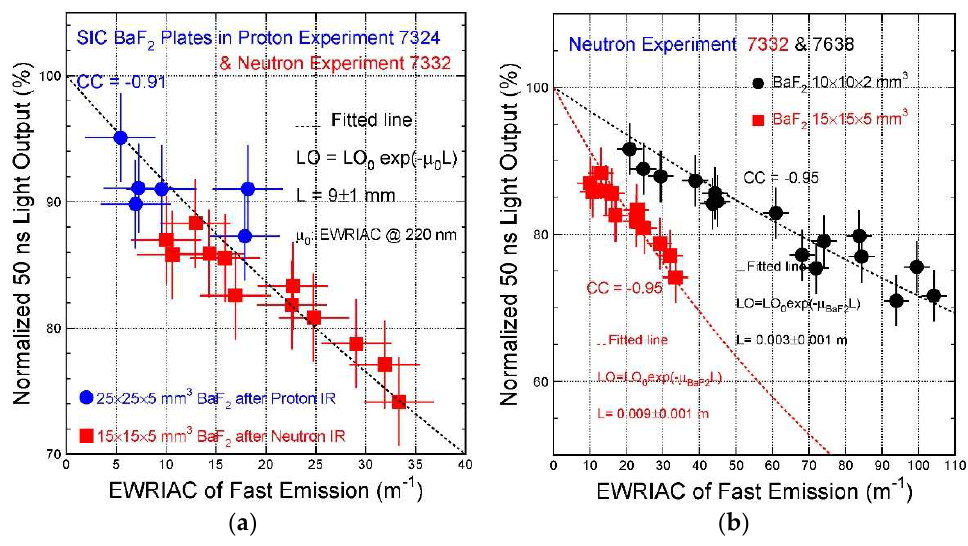
Figure 3. The normalized LO integrated in 50 ns gate is shown as a function of EWRIAC of the 220nm peak for the BaF 2 samples used in ( a ) the proton experiment 7324 and the neutron experiment 7332 [28], and ( b ) the neutron experiment 7332 and 7638, respectively.